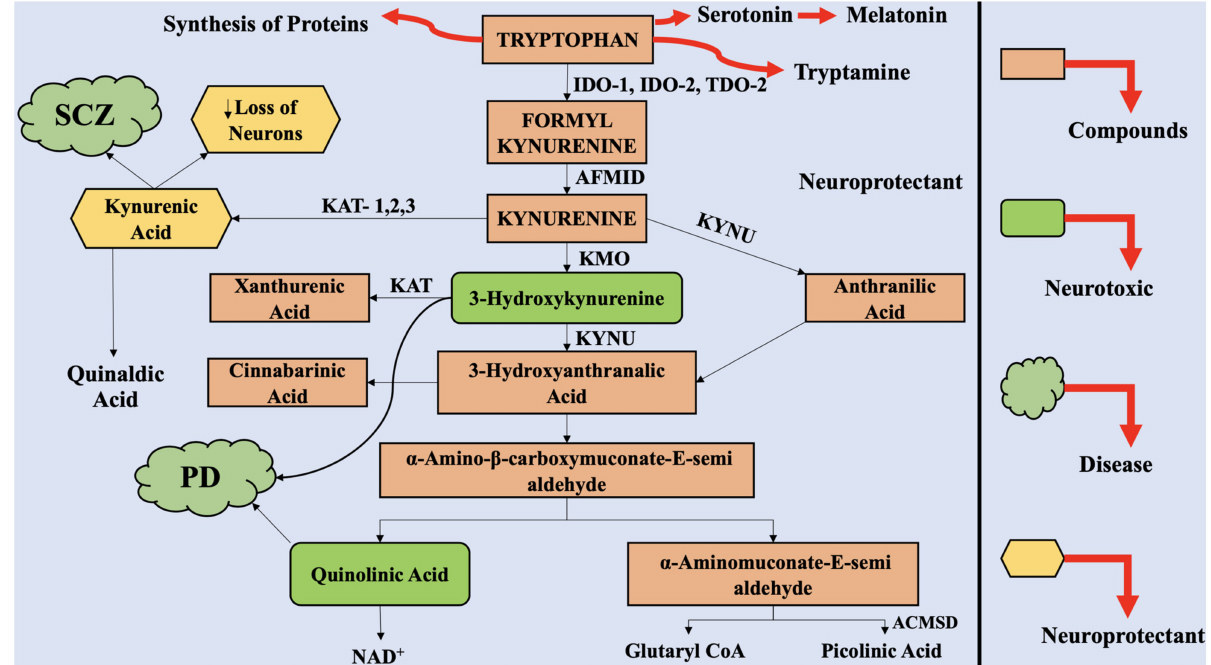
Figure 1. An overview of multiple steps involved in the kynurenine pathway, forming two significant metabolites: quinolinic acid and kynurenic acid. Legend: SCZ—schizophrenia, KYNU—kynureninase, IDO—indoleamine 2,3-dioxygenase, AFMID—arylformamidase, KMO—kynurenine 3-monooxygenase, KAT—kynurenine aminotransferase, PD—Parkinson’s disease, ACMSD—2-amino- 3-carboxymuconate-6-semialdehyde decarboxylase, CoA—coenzyme A, NAD+—nicotinamide adenine dinucleotide,